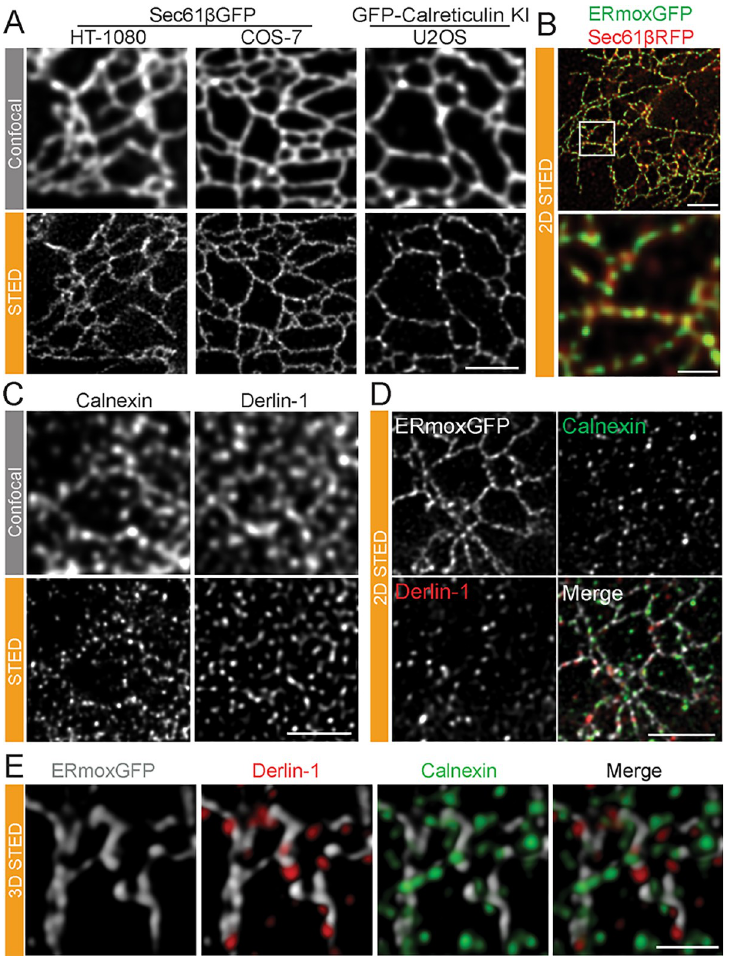
Fig 4. Periodic distribution of other ER markers and ER-resident proteins along peripheral ER tubules. (A) Representative confocal and STED images of live HT-1080 and COS-7 cells overexpressing Sec61 β GFP or live knock- in U2OS cells expressing GFP-calreticulin at endogenous levels. Scale bar, 2 μ m. (B) STED images of fixed HT-1080 cells expressing lumenal ERmoxGFP (green) and membrane Sec61 β mRFP (red) show distinct periodicity of these two ER reporters along peripheral ER tubules. Scale bar, 2 μ m; zoom, 0.5 μ m. (C) Untransfected HT-1080 cells labeled for derlin-1 or calnexin imaged by confocal and STED. Scale bar, 2 μ m. (D) Association of ER-resident proteins derlin-1 and calnexin with ERmoxGFP-labeled peripheral ER tubules in HT-1080 cells by 2D STED. Scale bar, 2 μ m. (E) Association of ER-resident proteins derlin-1 and calnexin with ERmoxGFP-labeled peripheral ER tubules in HT-1080 cells by 3D STED. Scale bar, 1 μ m. ER, endoplasmic reticulum; ERmoxGFP, ER monomeric oxidizing environment- optimized green fluorescent protein; KI, knock-in; STED, stimulated emission depletion; 2D, two-dimensional; 3D,